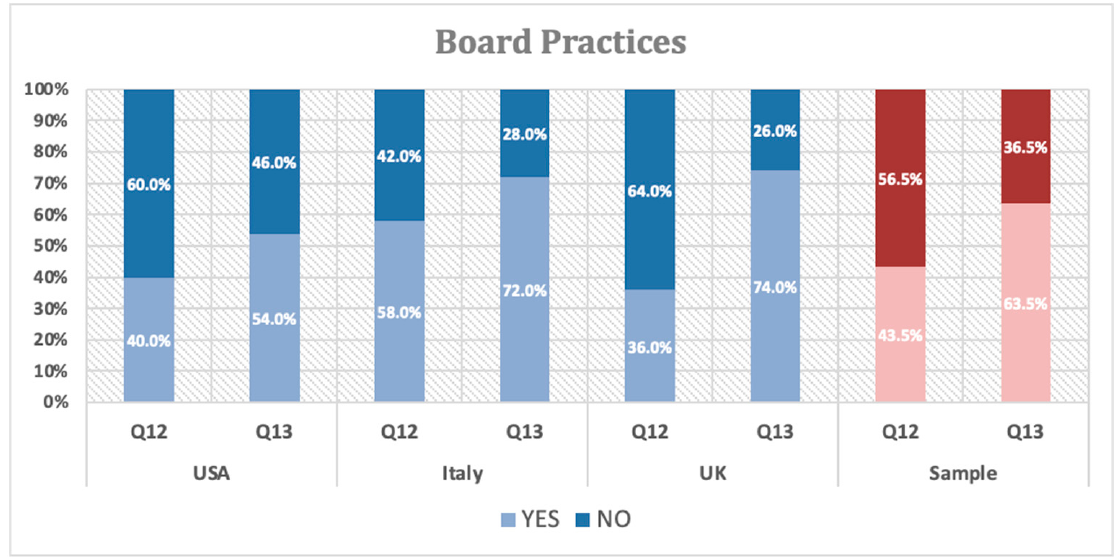
Figure 6. Answers to questions about the board practices (12 and 13) by country of respondents.